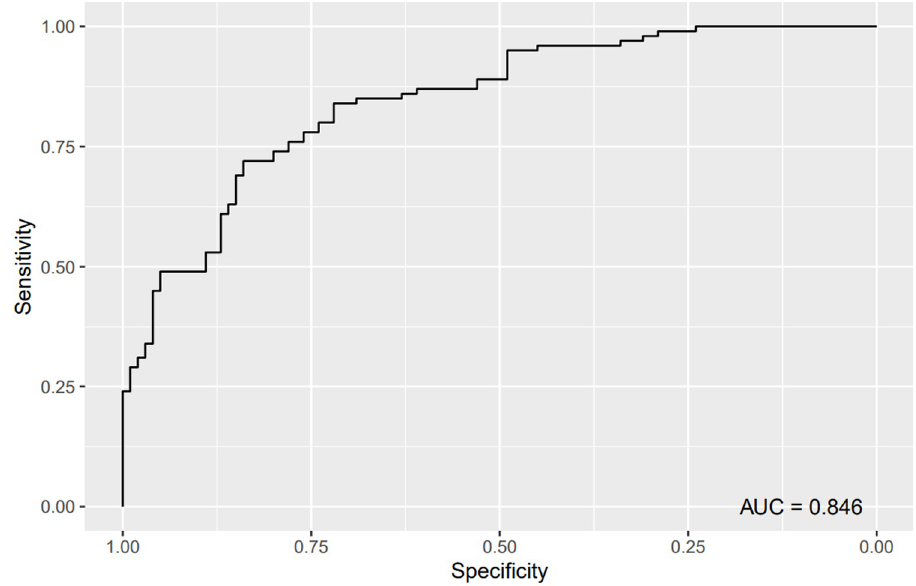
Fig 5. ROC-curve. ROC-curve of the conditional logistic model showing an excellent [19] prediction of cardiovascular related death (AUC = 0.846). The scale is described by Mandrekar [19] as follows: 0 indicates a perfectly inaccurate test, an AUC of 0.5 suggests no discrimination, 0.7 to 0.8 is considered acceptable, 0.8 to 0.9 is considered excellent, more than 0.9 is considered outstanding and a value of 1 reflects a perfectly accurate test.